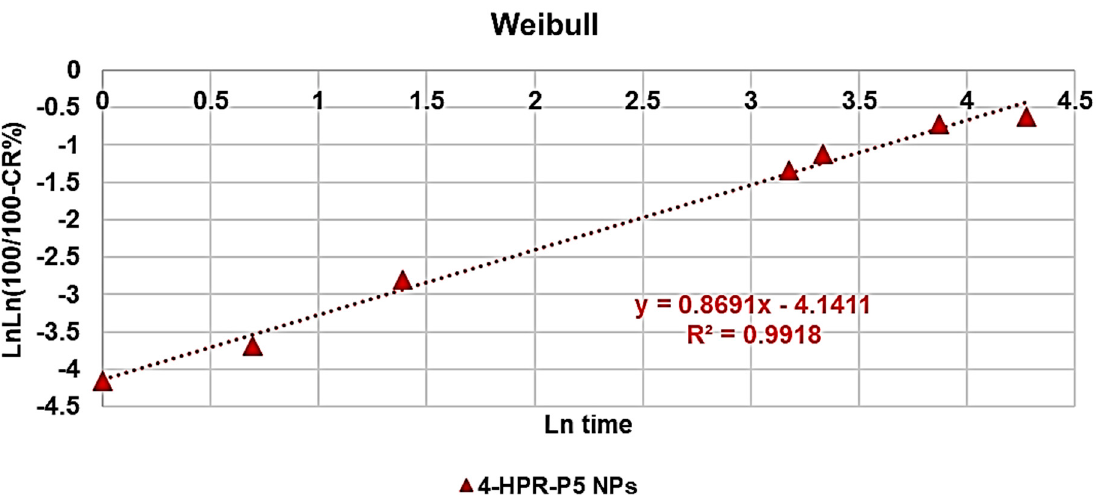
Figure 9. Linear regression of Weibull mathematical kinetic model with the related equation and R 2 value.